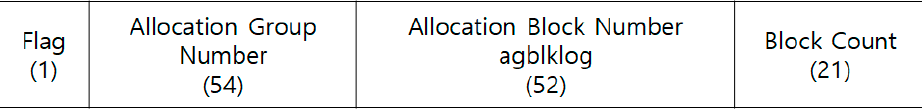
Figure 9. Structure of data extents of XFS file system. Figure 8. Directory entries structure of XFS file system.